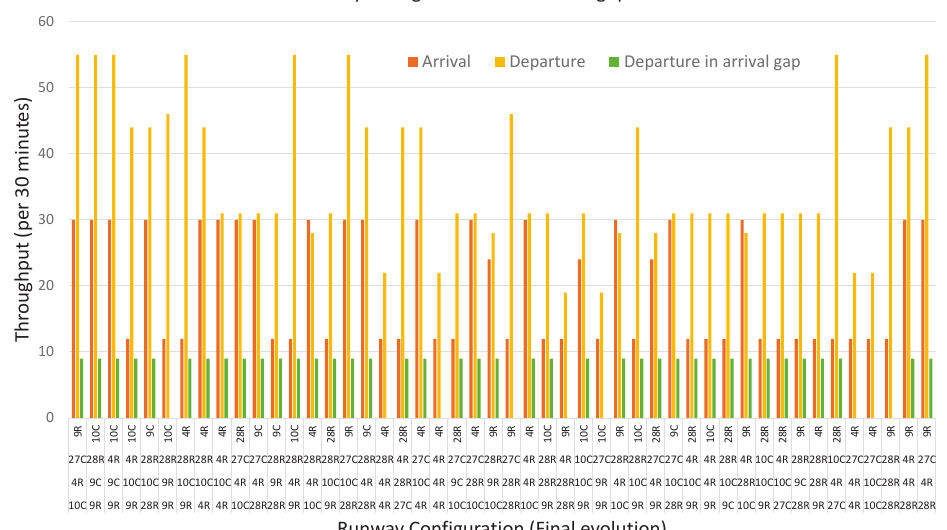
Figure 13. Runway configuration vs. throughput for all feasible configurations in the final